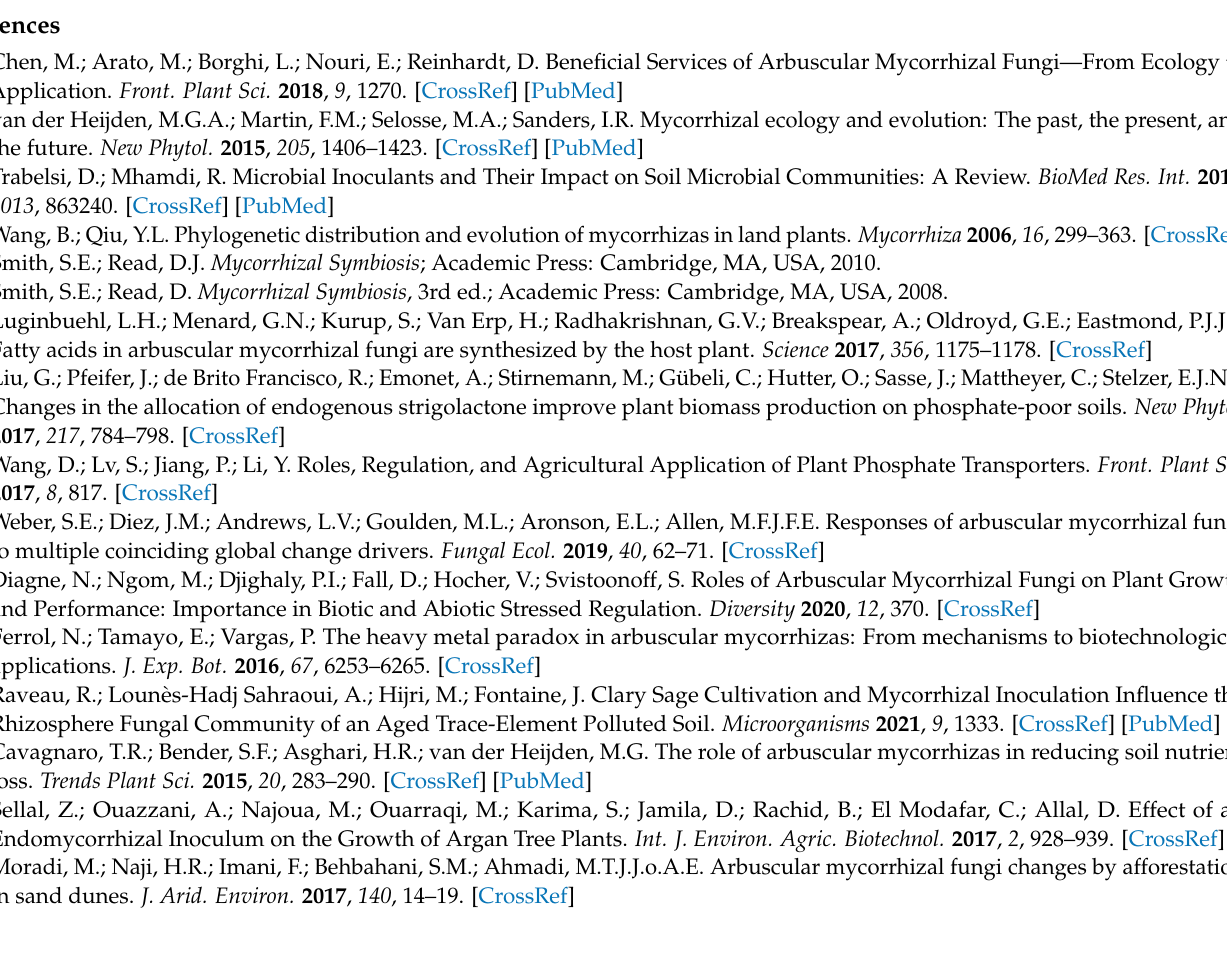
rank. Table S5: ASVs with assignment up to species taxonomic level (39 ASVs). Table S6: Shared ASVs (26) by the six sampling sites. Table S7: ASVs identified after indicator species